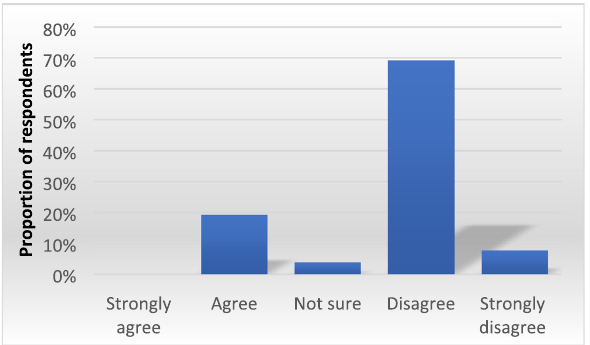
Fig. 5 Turf wars affect working relations in disaster risk reduction and climate change adaptation. Source Online survey of respondents in the Southern African Development Community study ( N =